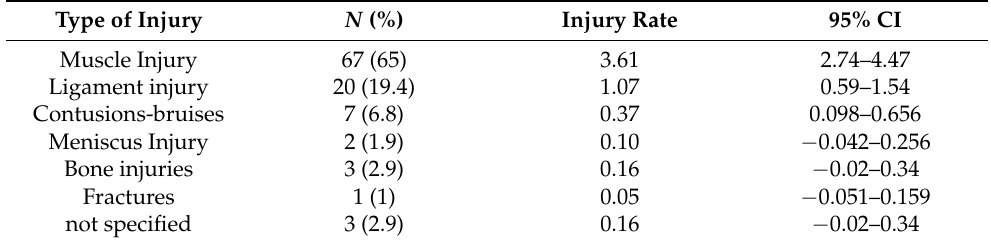
Table 2. Percentage of injuries, injury rate (number of injuries per 1000 h of exposure), and 95% confidence intervals (CI) according to the type of